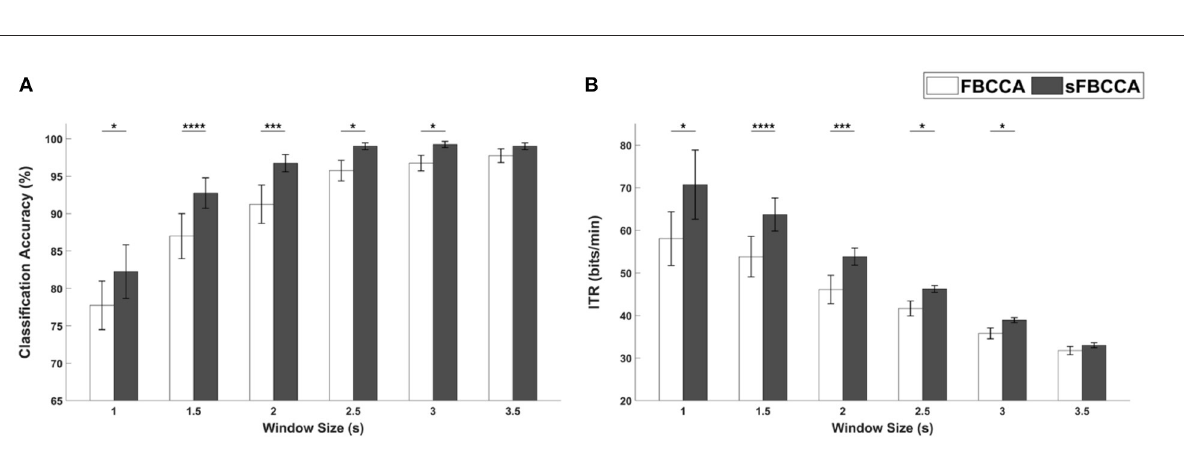
FIGURE10 (A) Classification accuracies and (B) ITRs of SSVEP-based BCI for PRS-Square evaluated using FBCCA and sFBCCA with different window sizes. Error bars represent the standard errors. Here, *, ***, and **** represent p < 0.05, p < 0.005, and p < 0.001, respectively (Wilcoxon signed-rank